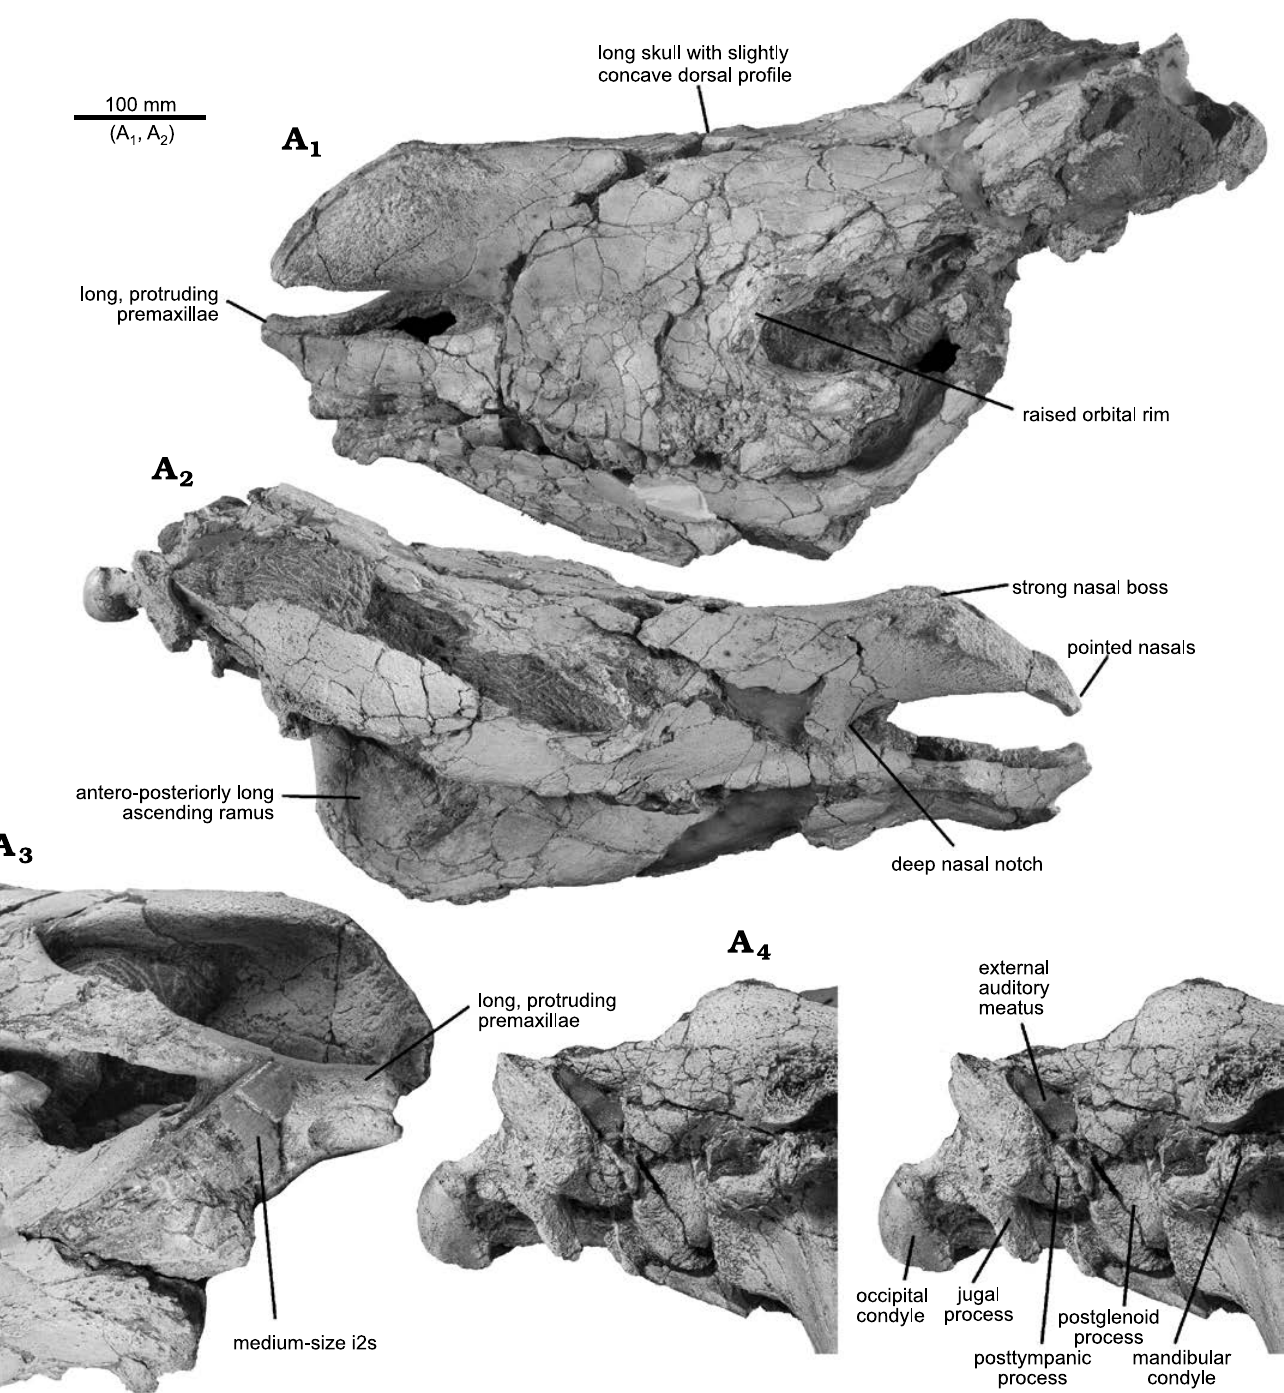
Fig. 1. Elasmotheriine rhinoceros Eoazara xerrii gen. et sp. nov. from the upper Miocene of Skoura, Morocco. Skull (FSC-Sk-250) in left latero-dorsal (A 1 ) and right lateral (A 2 ) views. Antero-ventral view of the front part, showing the right lower incisor, premaxillae, and nasals (A 3 ). Stereo view of the right auditory area (A 4 ). A 3 , A 4 , in oblique view, not to